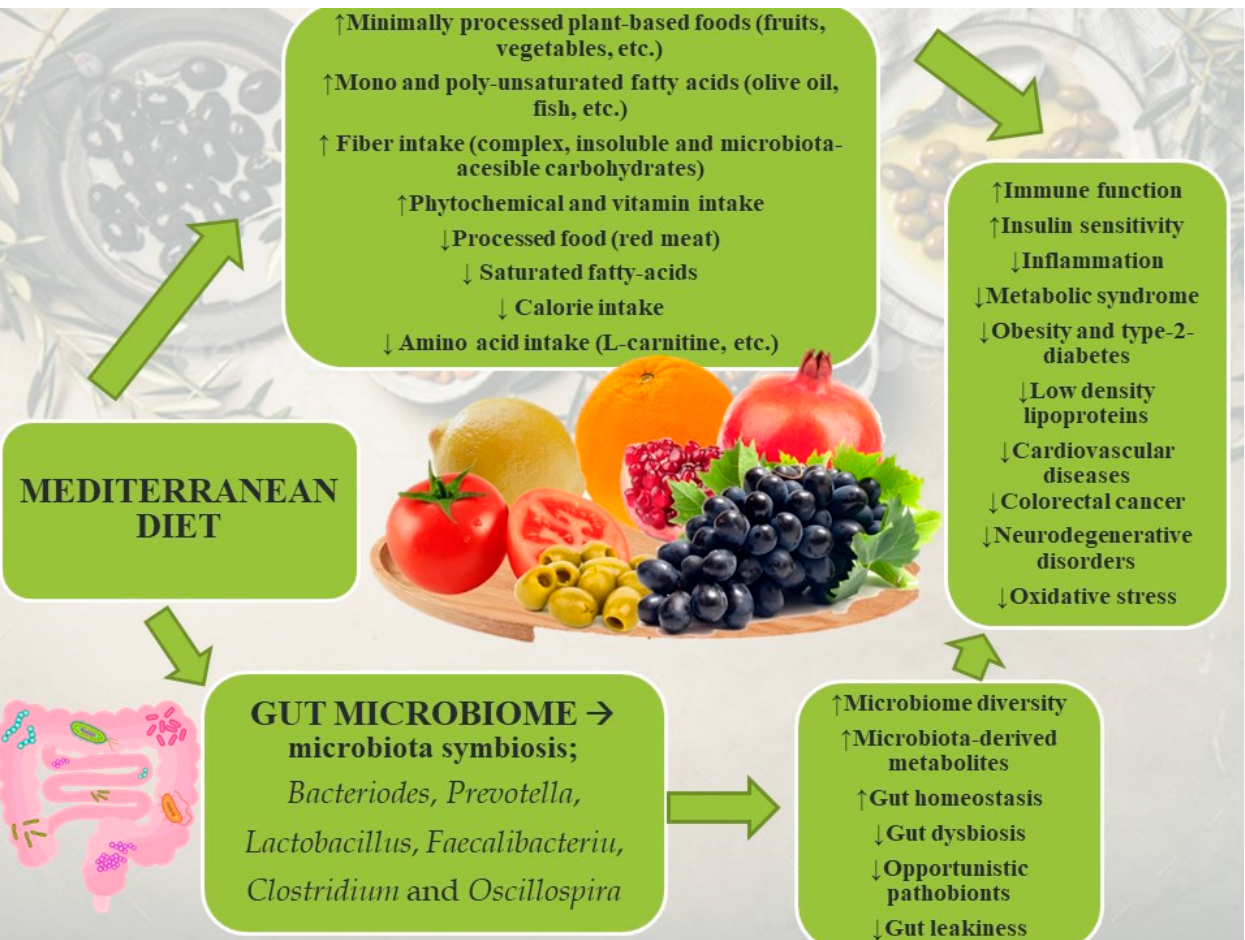
Figure 1. Characteristics of the Mediterranean diet and associated health benefits. The positive effects of the Mediterranean diet are also connected with specific effects on the microbiota composition.